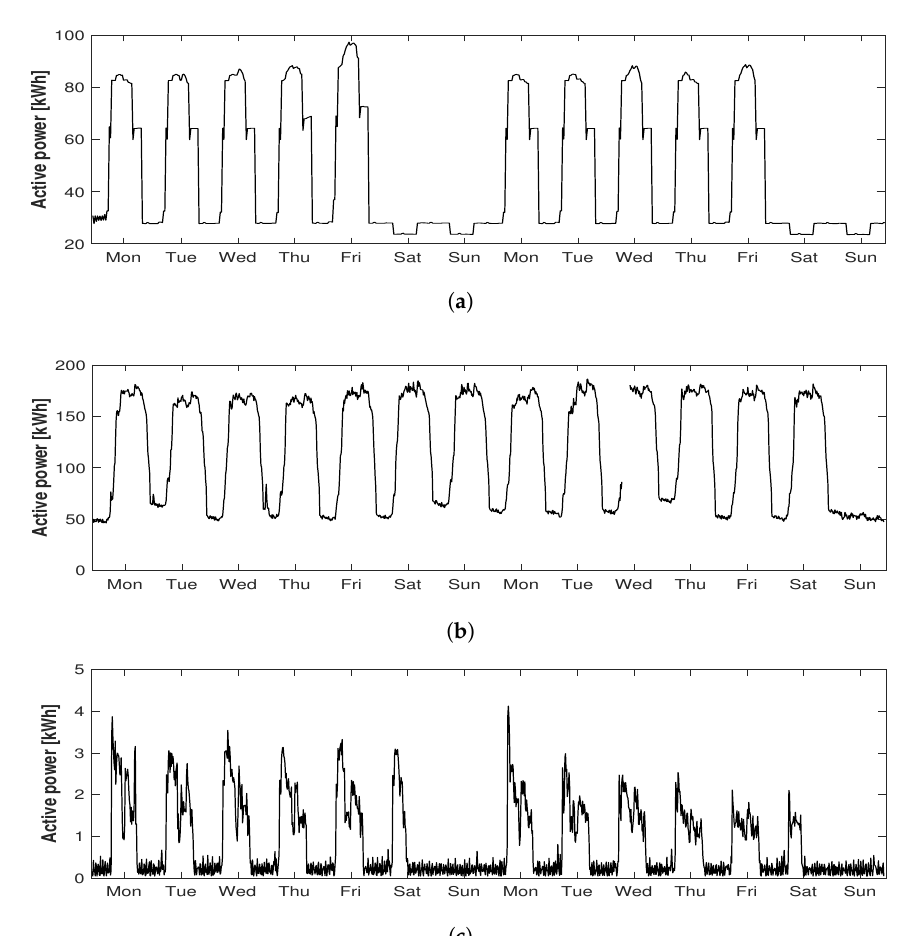
Figure 5. Example of data used in the performance evaluation. ( a ) DOE; ( b ) KEPCO-high voltage; ( c ) KEPCO-low